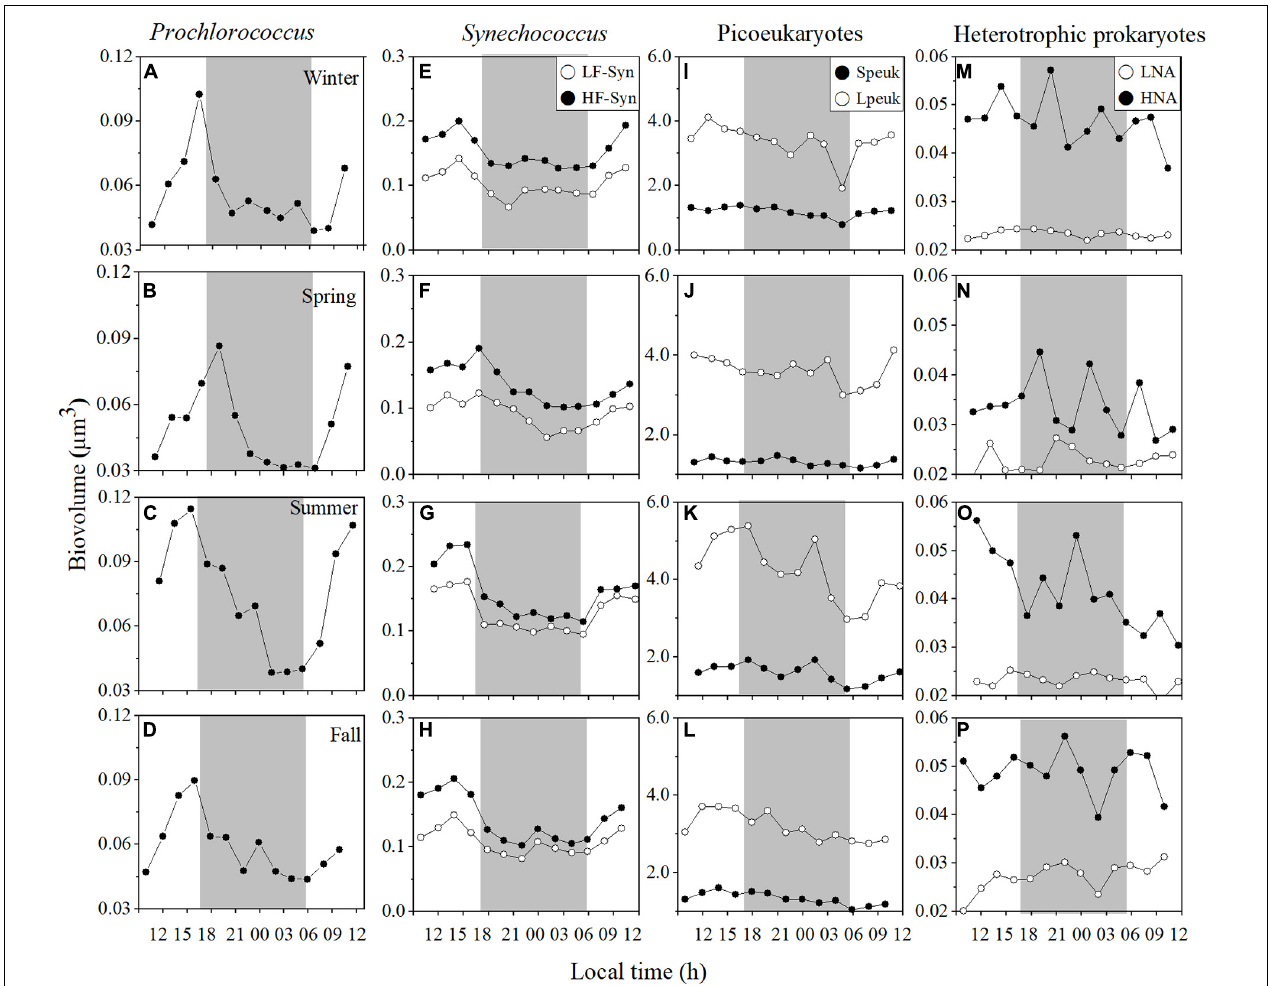
FIGURE 3 | Diel variation in picoplankton cell size at the surface of the study site in winter, spring, summer, and fall. Prochlorococcus (A–D) low (LF-Syn, open circles) and high (HF-Syn, filled circles) fluorescence Synechococcus (E–H) , small (Speuk, filled circles) and large (Lpeuk, open circles) picoeukaryotes (I–L) , low (LNA, open circles), and high (HNA, filled circles) nucleic acid content heterotrophic prokaryotes (M–P) . The gray shading represents